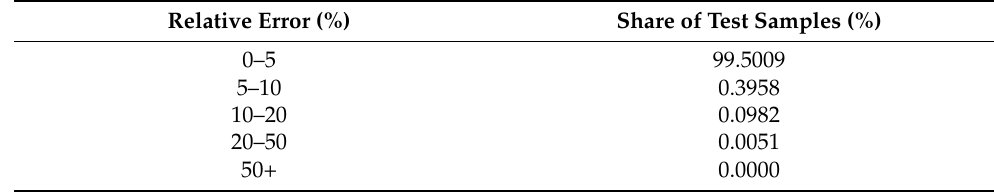
Figure 6. Distribution of occurrence for prediction errors for an ensemble model based on 4-layer models with 280 nodes per layer after transformation of the output values into a quasi-normal distribution. Table 9. Function loss values on the test dataset along epochs for an ensemble model based on 4-layer models with 280 nodes per layer after transformation of the output values into a quasi-normal distribution.